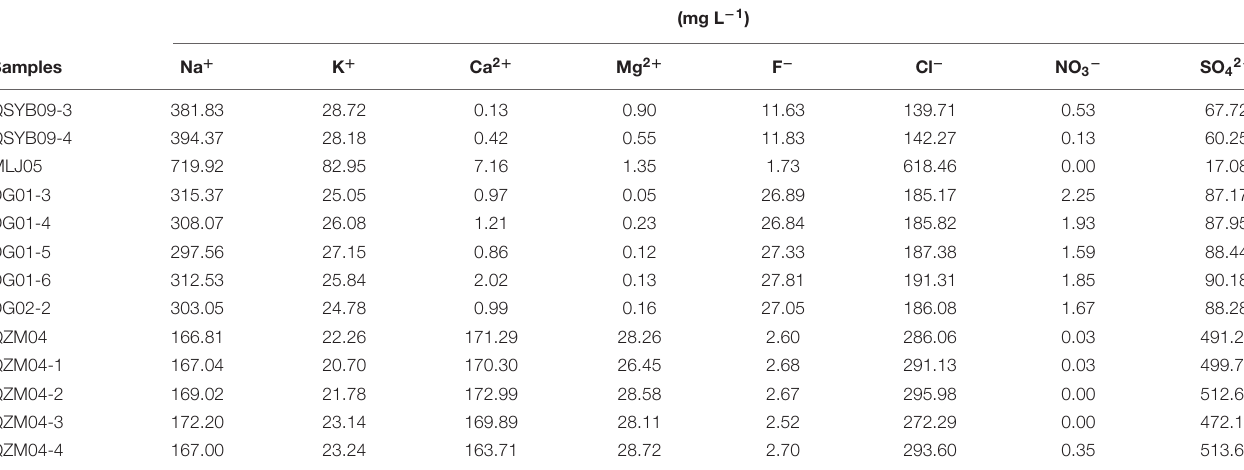
TABLE 2 | Concentrations of major ions of the investigated hot springs in present study.